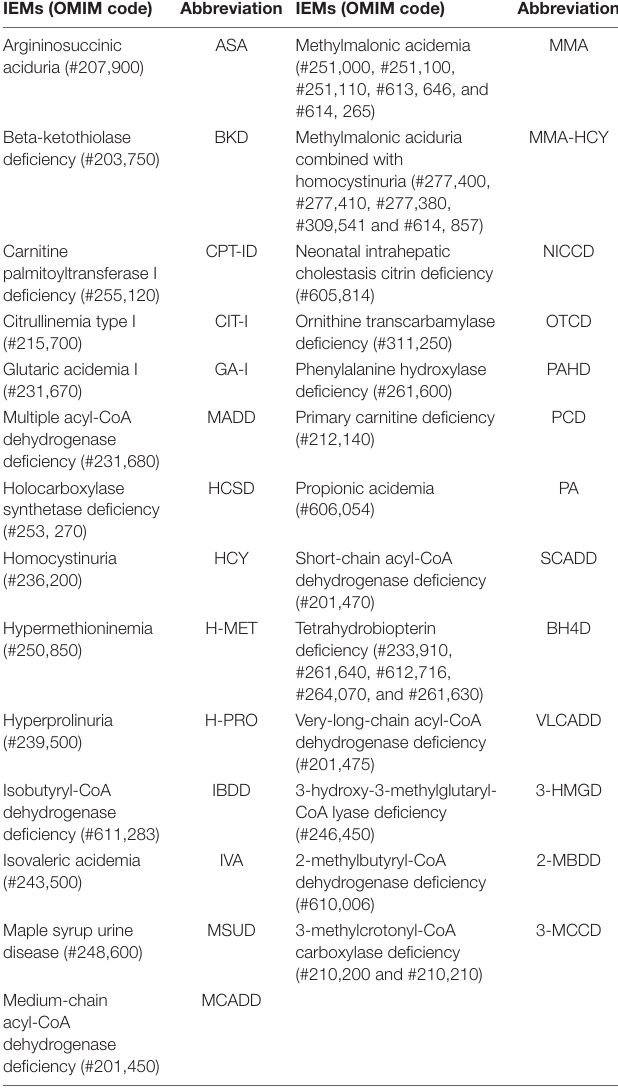
TABLE 1 | Panel of the artificial intelligence (AI) disease risk assessment